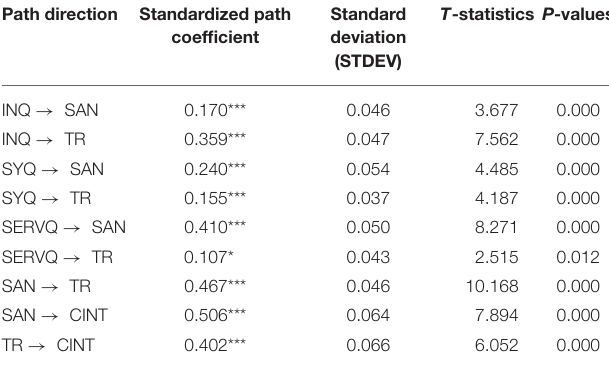
TABLE 6 | Inner model analysis